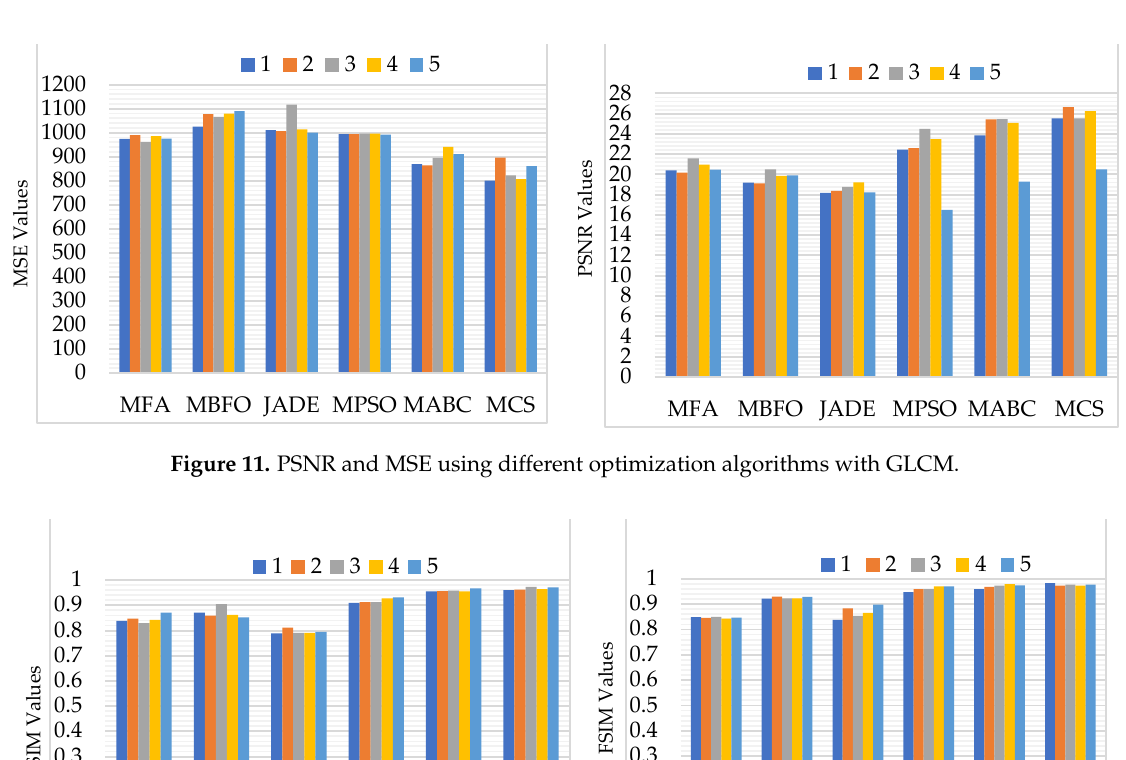
Table 9. SSIM and FSIM using different optimization algorithms with the GLCM method.